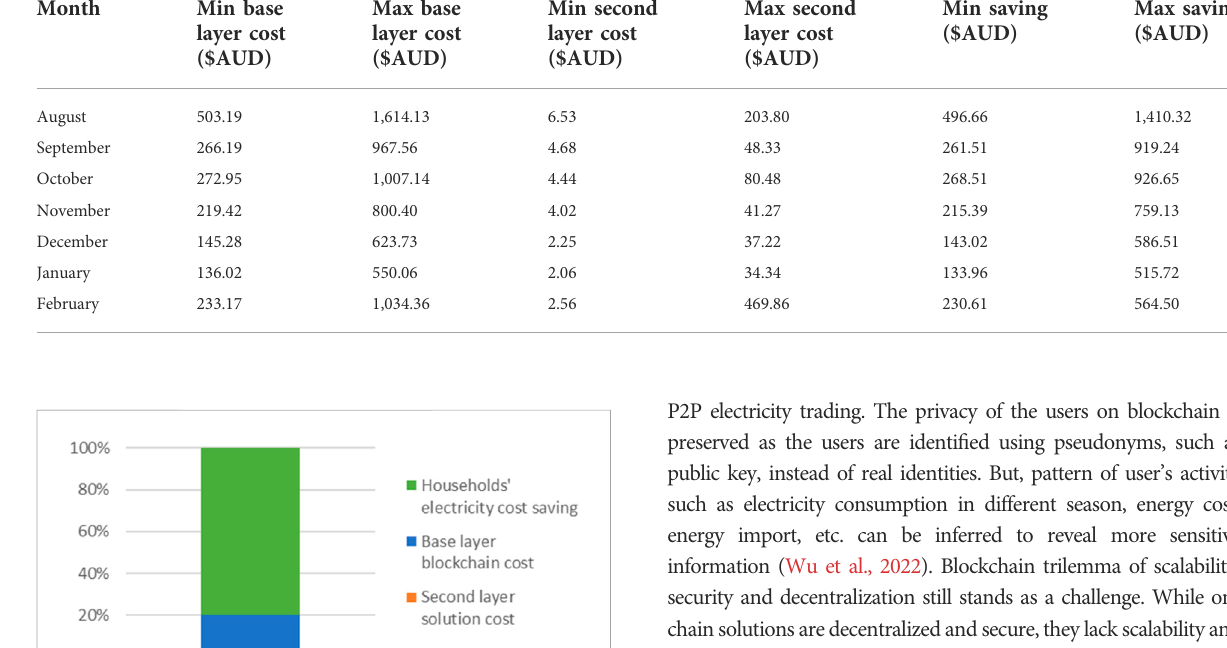
FIGURE 7 Comparison of the cost of electricity saved by homes, the cost of the base layer blockchain, and the cost of the second layer solution in